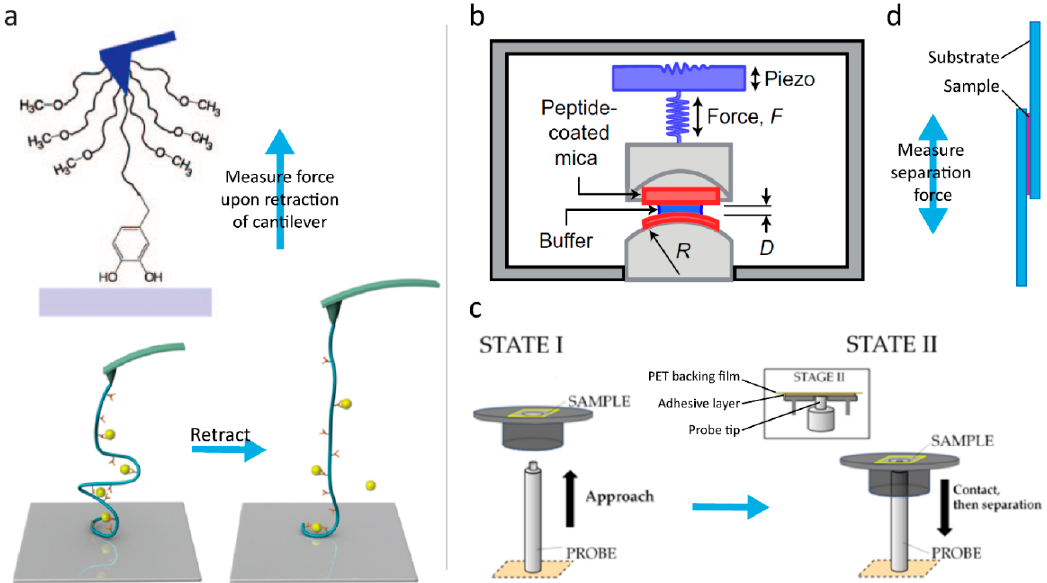
Figure 3. Methods of evaluating bonding strength. ( a ) Atomic force spectroscopy used for probing the strength of single-molecule adhesion (top) and catecholato–Fe(III) coordination bonds cross-linking a polymer (bottom). The sample is fixed on a cantilever and the strength is evaluated by measuring the force needed to retract the Sciences of the USA. (Bottom) Reprinted (adapted) with permission from [33]. Copyright 2017 American Chemical Society. ( b ) Set-up of a surface forces apparatus: The sample is fixed on mica surfaces that are brought in contact, and the separation force is measured. Reprinted by permission from MacMillan Publishers Ltd. [27], Copyright 2017. ( c ) Set-up of a Probe Tack device: The sample is fixed on a backing film (here polyethylene terephthalate (PET)) and brought in contact with a probe, which is then retracted and the adhesion force evaluated. Reprinted (adapted) with permission from [53]. Copyright 2016 American Chemical Society. ( d ) Lap-shear test: The sample is fixed between two pieces of overlapping substrate and the adhesion force is measured when separating the substrates in the direction indicated by the arrow.